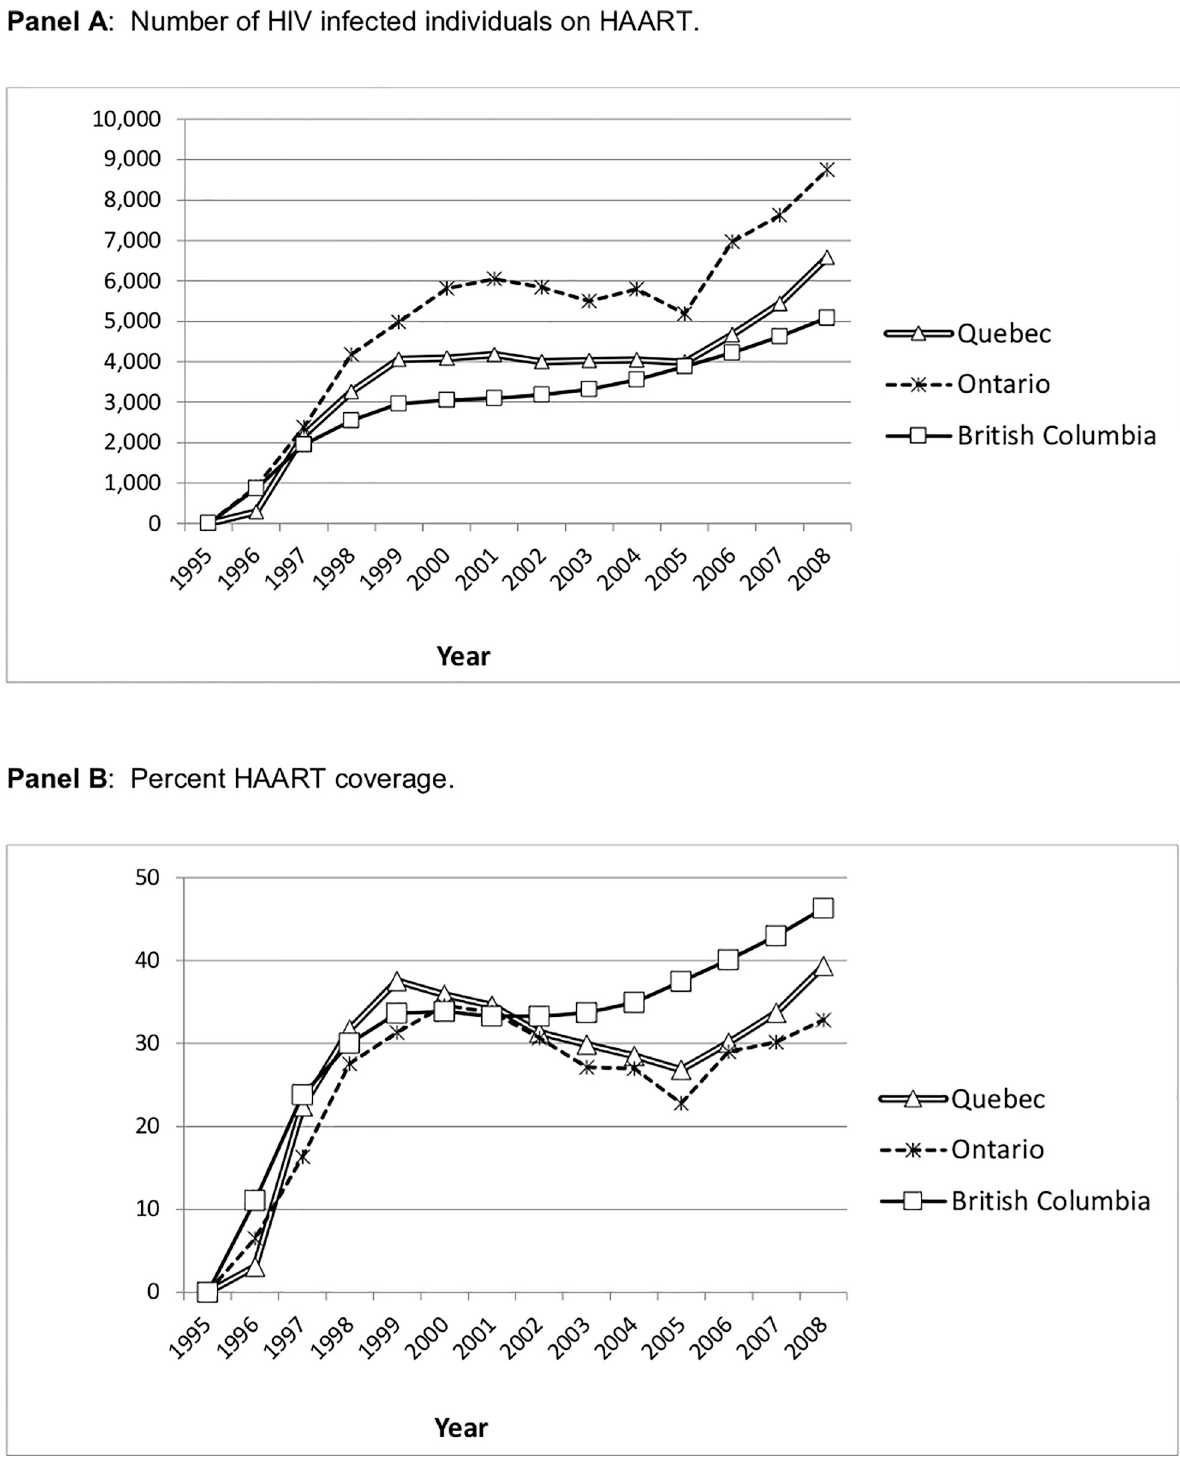
Fig 2. HAART use in British Columbia, Ontario and Quebec, 1995–2008. Panel A: Number of HIV infected individuals on HAART. Panel B: Percent HAART coverage.